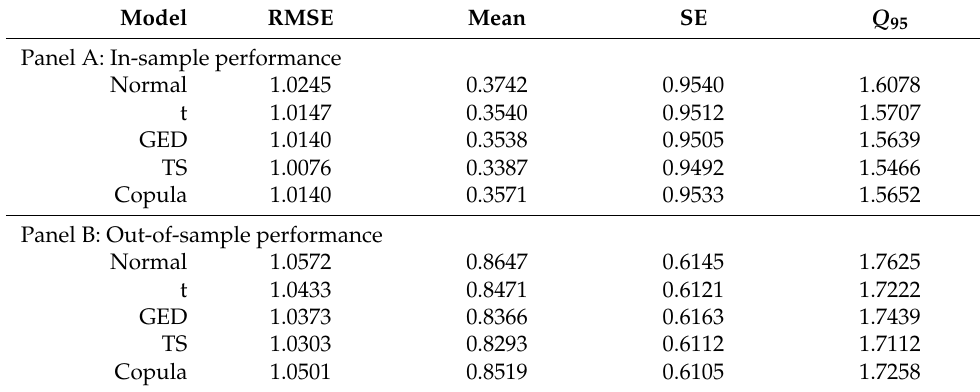
Figure 2. Fitted conditional variances of CGARCH Models. ( a ) Normal distribution. ( b ) Student’s t- distribution. ( c ) GED. ( d ) Tempered stable distribution. Table 5. Forecasting performance